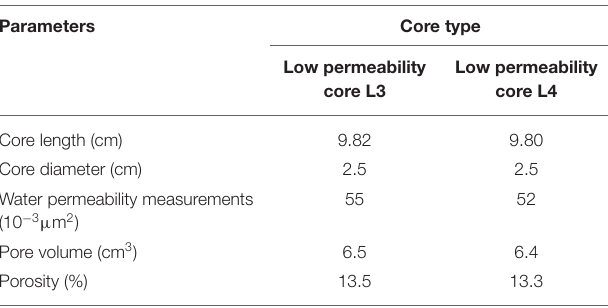
TABLE 2 | 50 10 − 3 µ m 2 Core ×